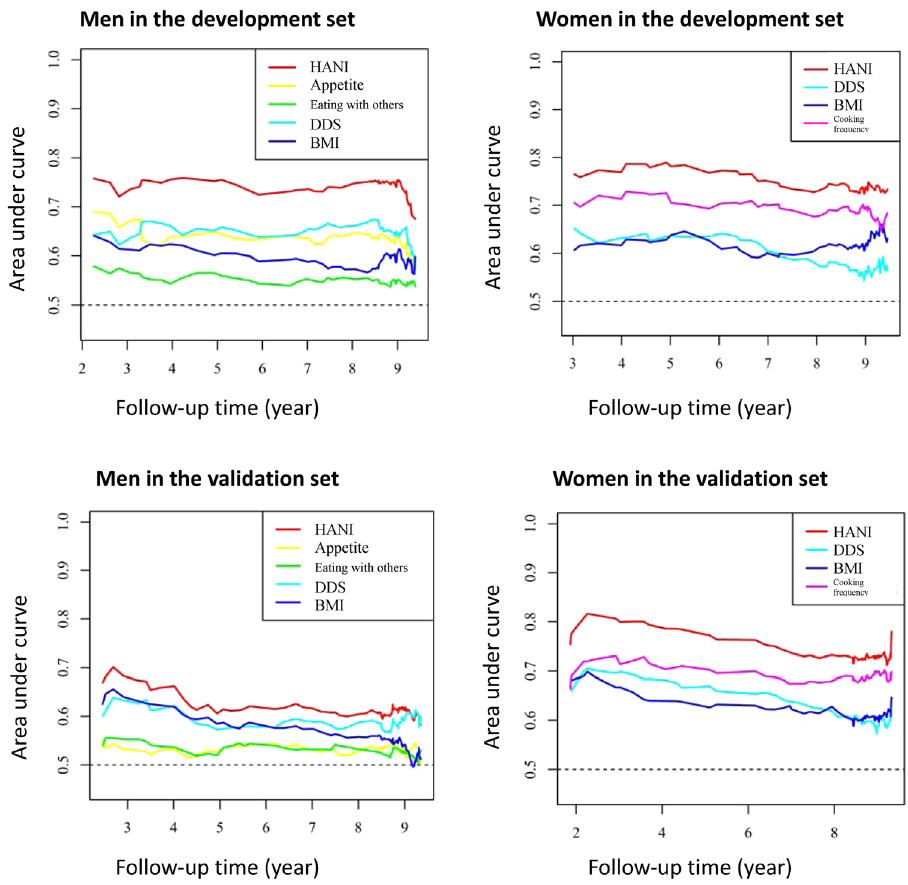
Figure 1. Area under curve of time-dependent receiver operating characteristic for HANI score and each component. HANI, Healthy Ageing Nutrition Index; DDS, dietary diversity score; BMI: body mass